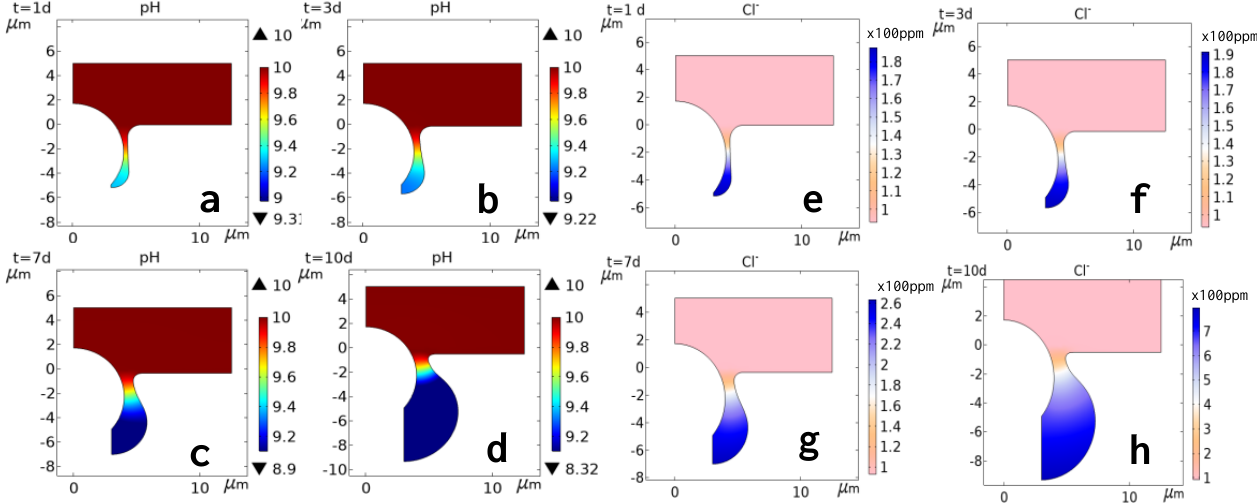
Figure 8. The pH and Cl − diffusion at different times. ( a – d ) culated results of pH at 24 h, 72 h, 168 h, and 240 h, ( e – h ) alculated results of Cl − diffusion at 24 h, 72 h, 168 h, and 240 h. On this scale, 1 represents 100 ppm concentration.